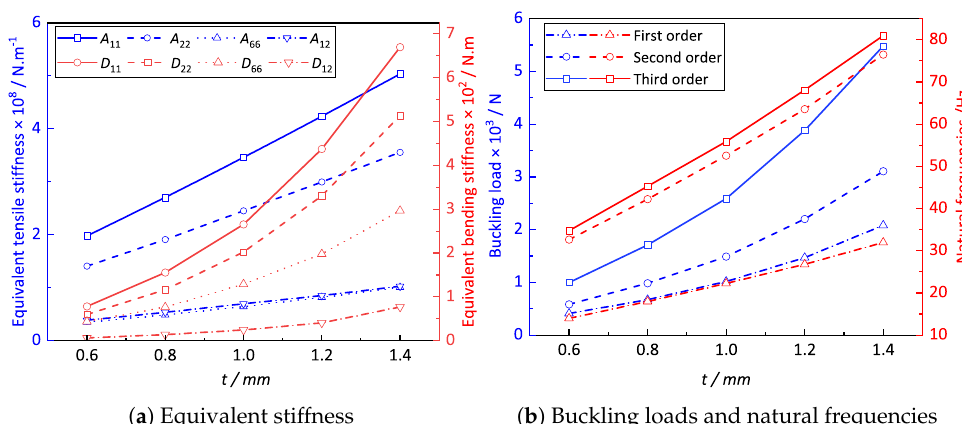
Figure 12. The influence of t on the effective performance of CCCP.